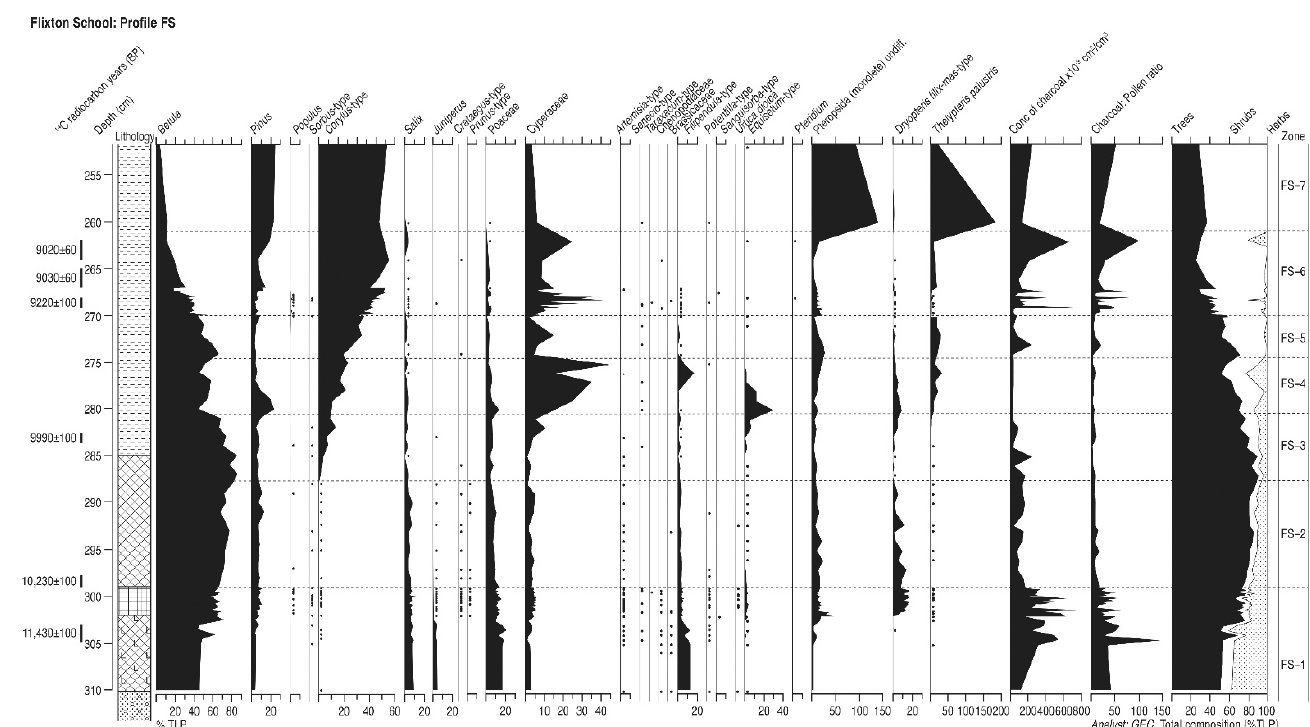
Figure 9. Percentage pollen diagram from Flixton School profile FS (Analysis GEC).